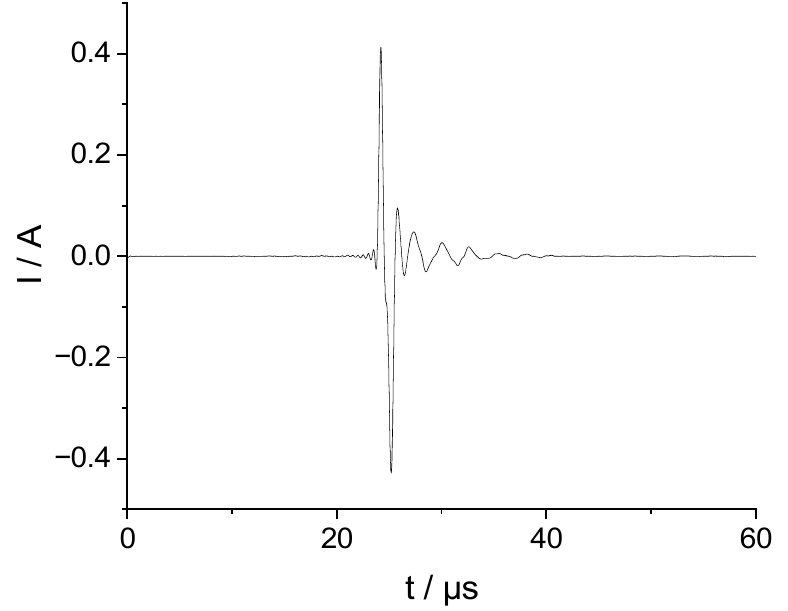
Figure 3. Electric current into the transducer when it acts as sender. The current I ( t ) was low pass filtered with a cut-off frequency of 2 MHz.